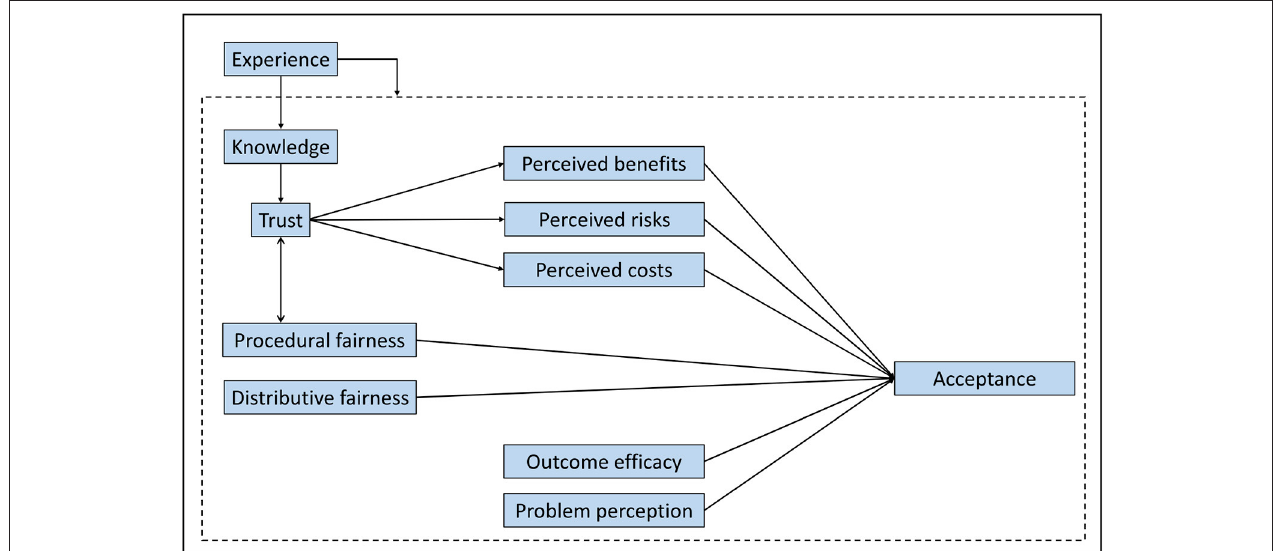
FIGURE 1 | An illustrative representation of the model for the social acceptance of shale gas development.